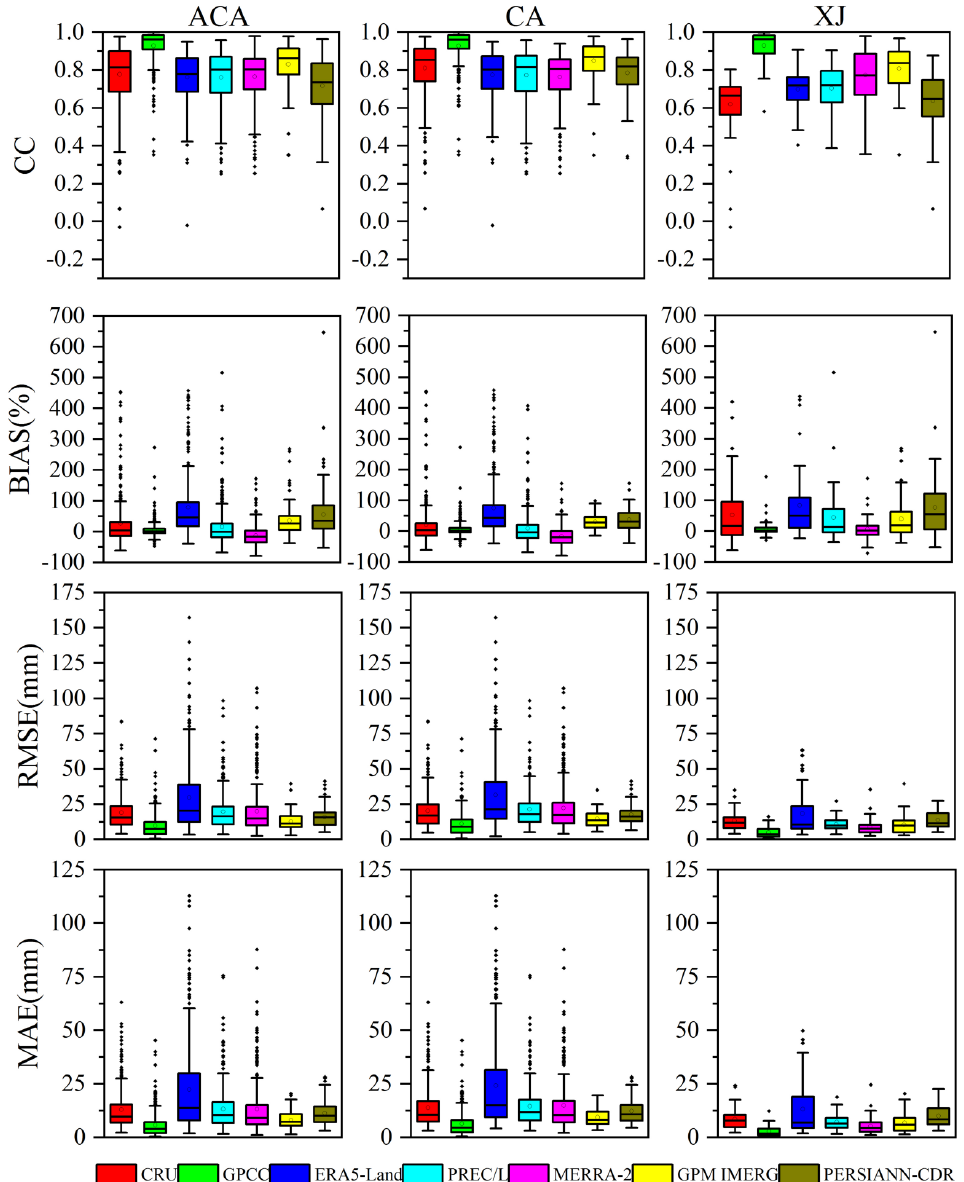
Figure 8. Performance of monthly precipitation evaluated by the four indices (points represent the outliers. For the whiskers, the upper and lower boundaries represent the maximum value and minimum value, respectively. For the color boxes, the top, middle, and bottom black lines represent the first quartile value, the median value, and the third quartile value, respectively).